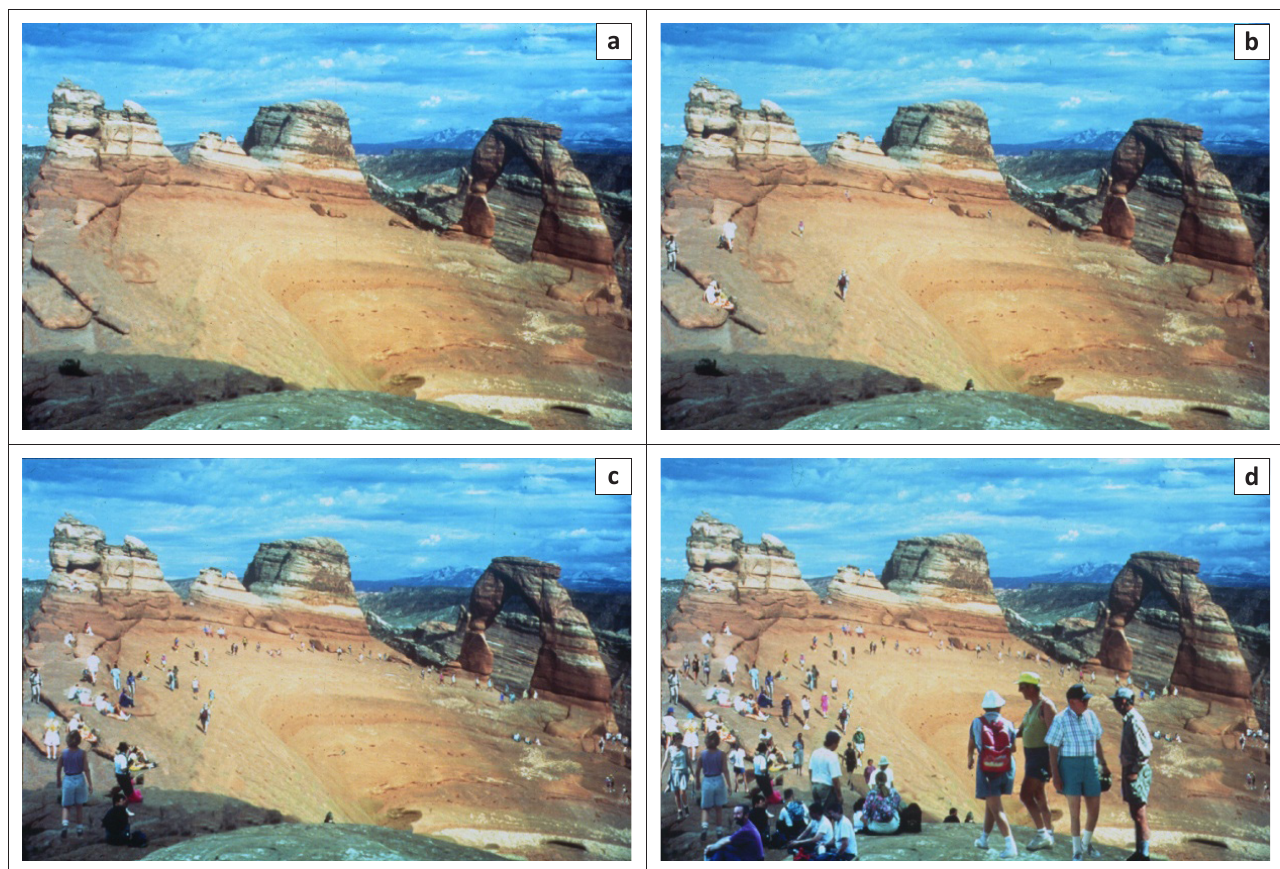
FIGURE 2: Sample computer-generated photographs illustrating a range of use levels in terms of people at one time at Delicate Arch in Arches National Park, Utah, with (a) 0 people, (b) 12 people, (c) 52 people and (d) 108 people.